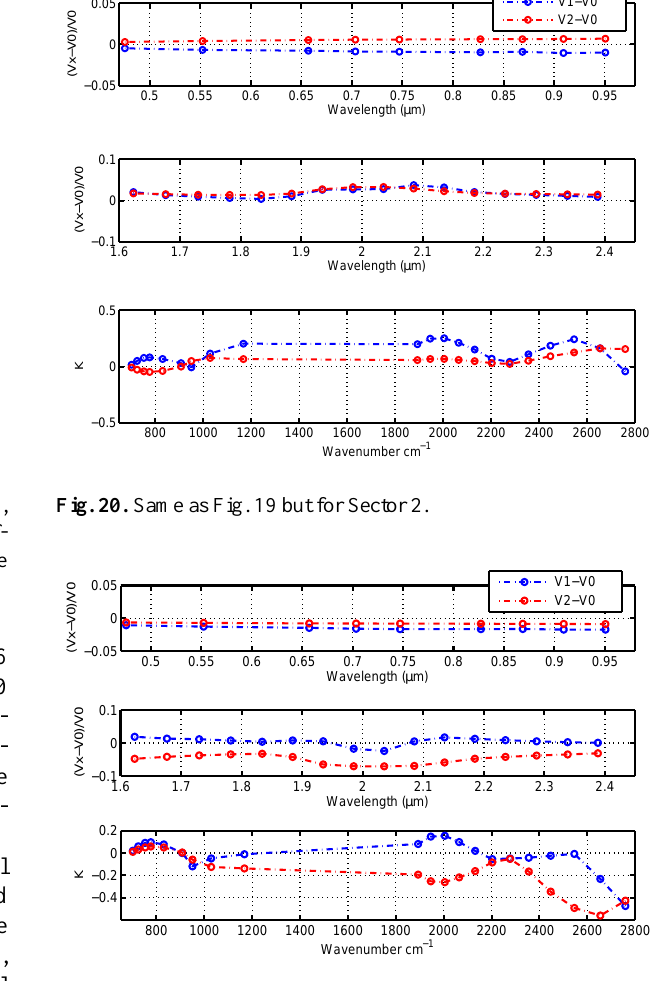
Fig. 21. Same as Fig. 19 but for Sector